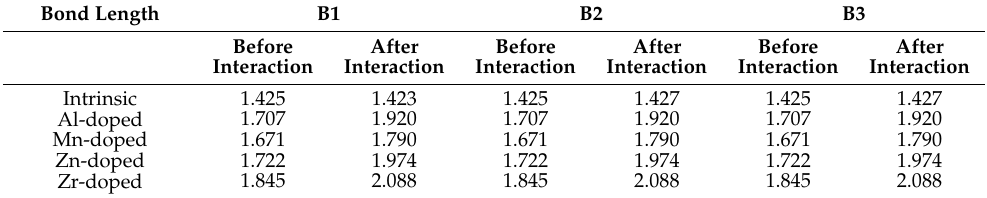
Table 1. Energies of the intrinsic graphene and doped graphene (Al, Mn, Zn, and Zr) following the DFT calculation (unit: eV).